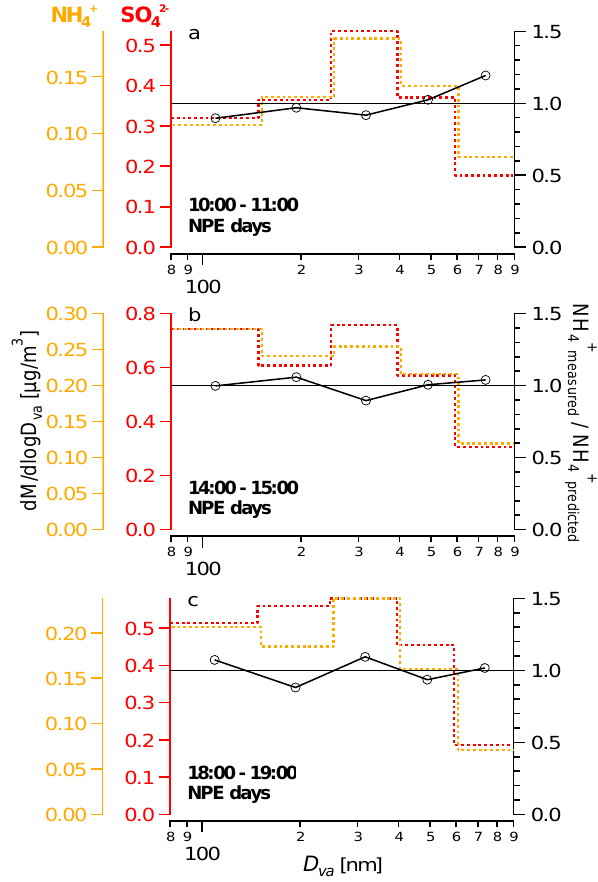
Figure 10. Size distributions of SO 2 − of measured NH +